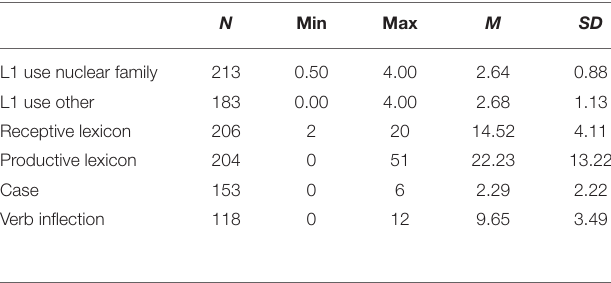
TABLE 1 | Descriptive statistics for input measures and language measures.